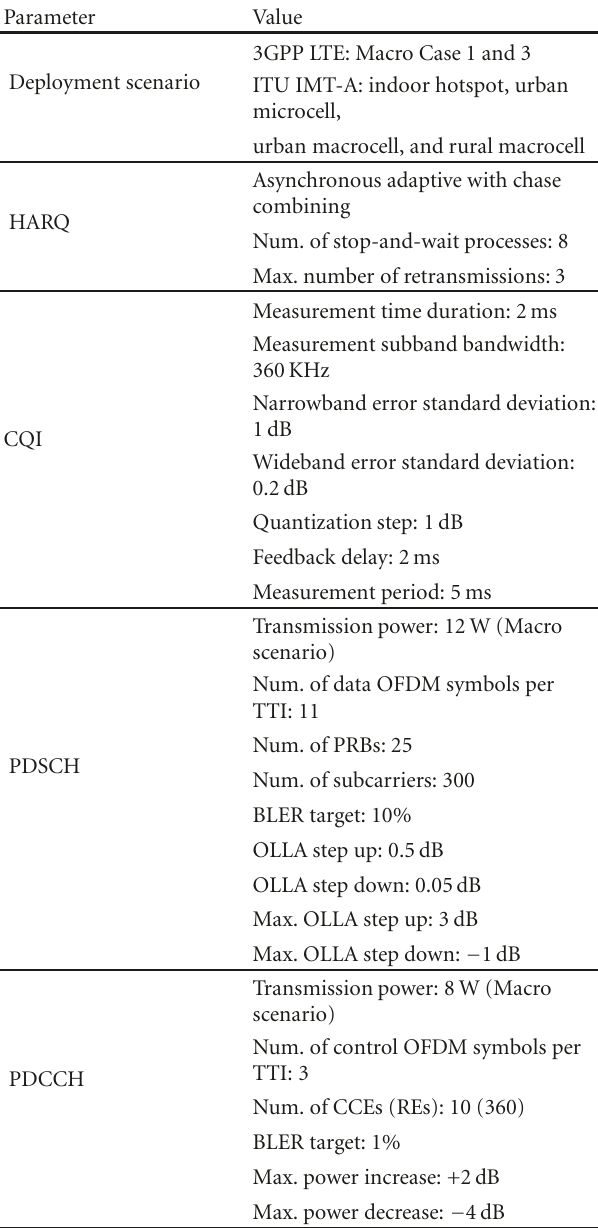
Table 1: Main simulation parameters and